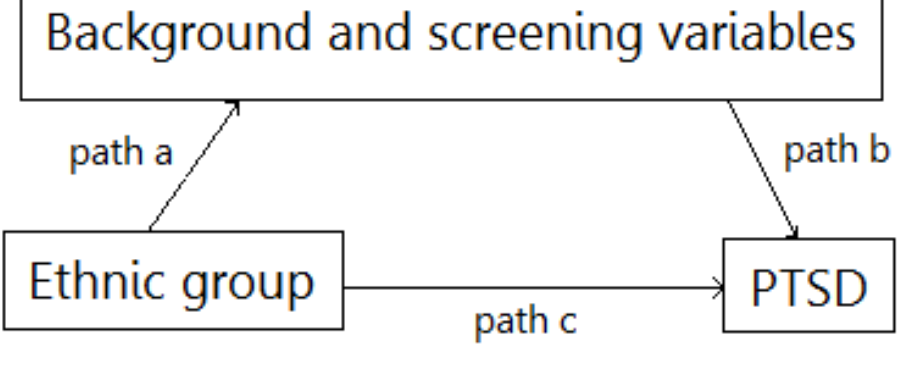
Figure 1. The unstandardized path coefficients indicate the direct effects of the ethnic group on the mediators—background and screening variables (path a), the direct effects of mediators on PTSD prevalence (path b) and the direct effect of ethnic group on PTSD (path c) are presented in Table 4. The estimations of the indirect effects, including the bootstrapping CIs, are also presented in Table 4. As can be seen, previous trauma, hospital- ization duration, child’s and parent’s previous functioning and the child’s anxiety level during hospitalization significantly mediated the relationship between the ethnic group and PTSD. Previous trauma mediation was partial (path c remained significant) while other mediations were full.